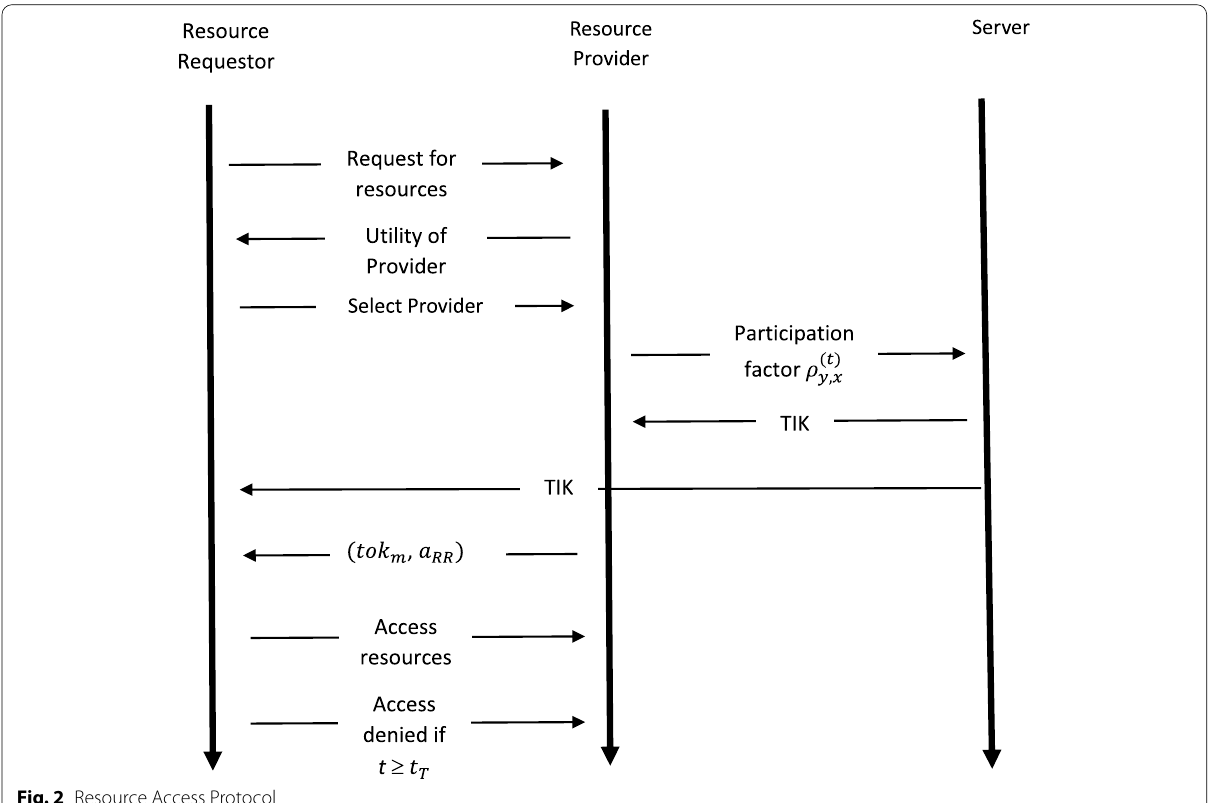
Fig. 2 Resource Access